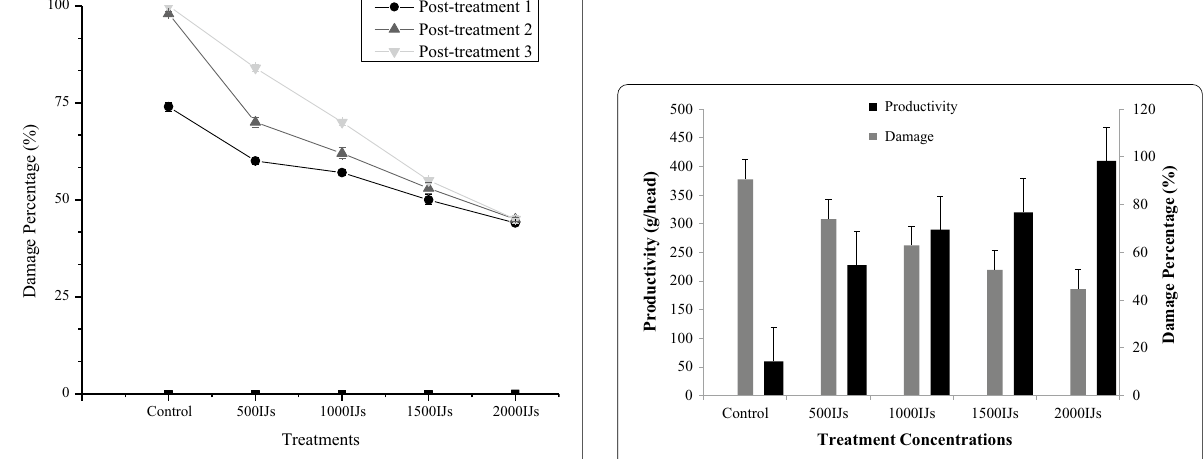
Fig. 3 Leaf damage percentage by Pieris brassicae larvae after three constitutive foliar applications of entomopathogenic nematodes under field conditions